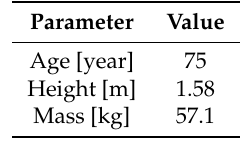
Table 2. Detail of a user of support